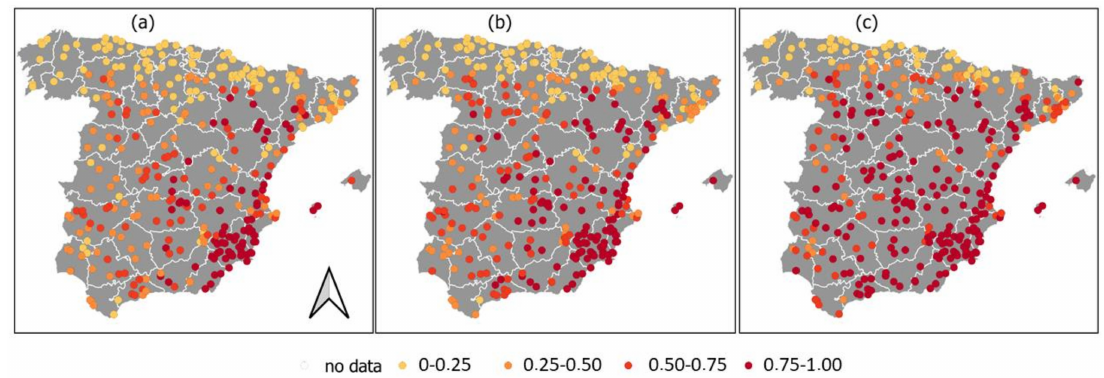
Figure 3. Average value of the static stress indicator in Spain over the periods 2006–2040 ( a ); 2041–2070 ( b ); and 2071–2100 ( c